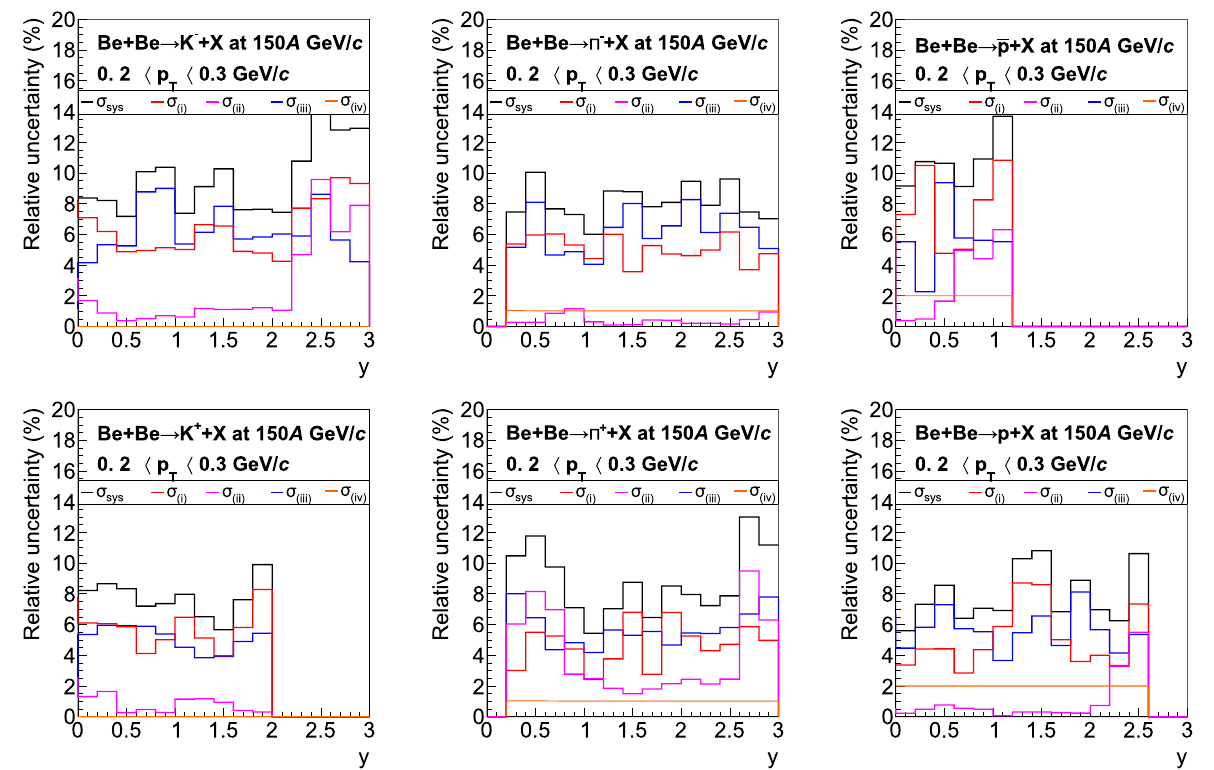
Fig. 17 Contributions to the systematic uncertainty of particle spec- and σ (iv) (orange lines) to the contamination by feeddown from weak tra obtained from the d E / d x method at 150 A GeV / c as a function of decays of strange particles. Black lines, σ (sys) , show the total systematic rapidity for the transverse momentum interval between 0.2–0.3 GeV / c . uncertainty calculated as the square root of the sum of squares of the σ σ components (i) (red lines) refers to event selection (ii) (magenta lines) to the track selection procedure, σ (iii) (blue lines) to the identification technique